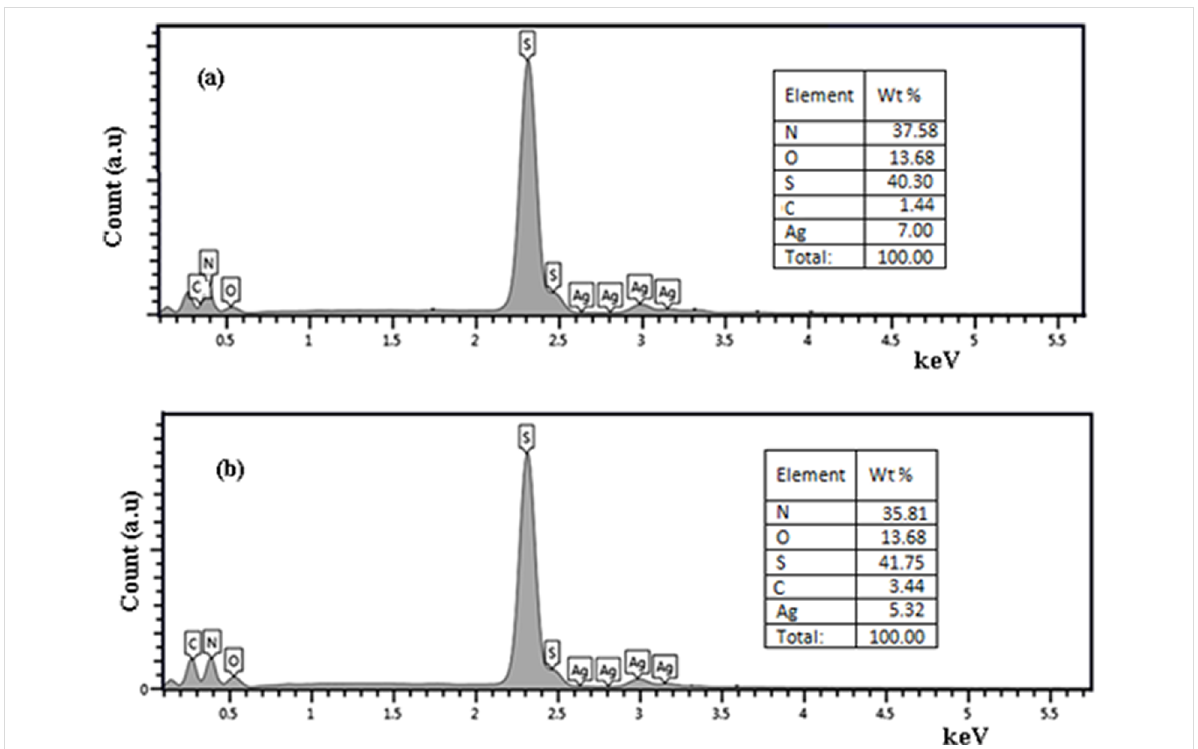
Figure 10: EDX of Ag 2 S NPs synthesized in (a) pure Tu and in (b) Tu with CTAB. The inset shows the measured elements.